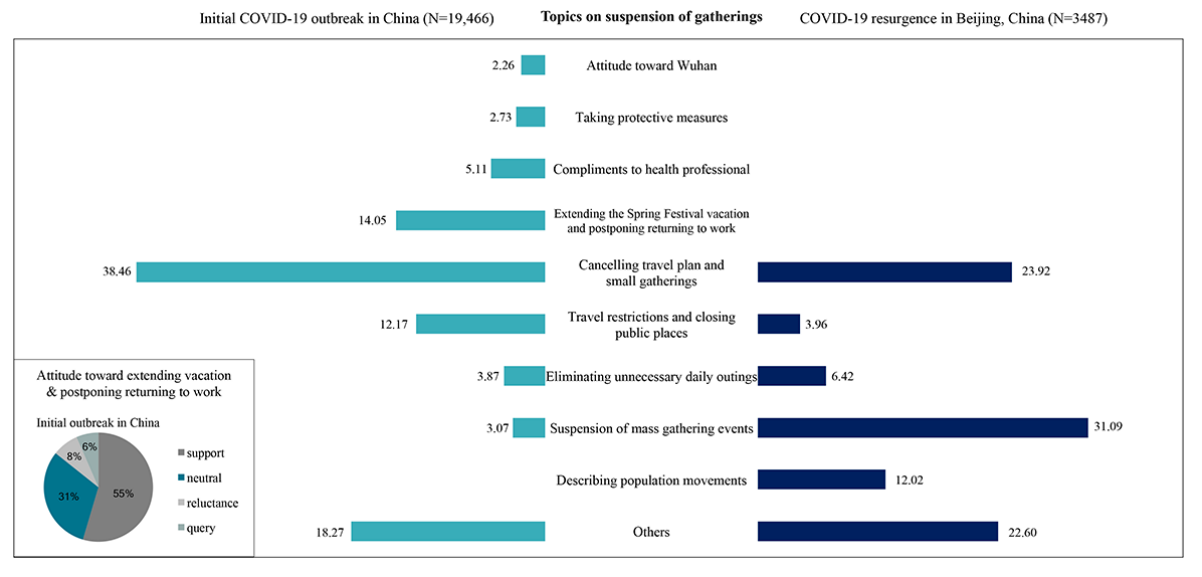
Figure 6. Proportion of posts related to frequently discussed topics on the suspension of gatherings during the initial outbreak and the resurgence of COVID-19 in China. The columns show the proportion of posts on each topic among all posts related to the suspension of gatherings. Pie charts show the proportion of various attitudes toward some topics during the initial